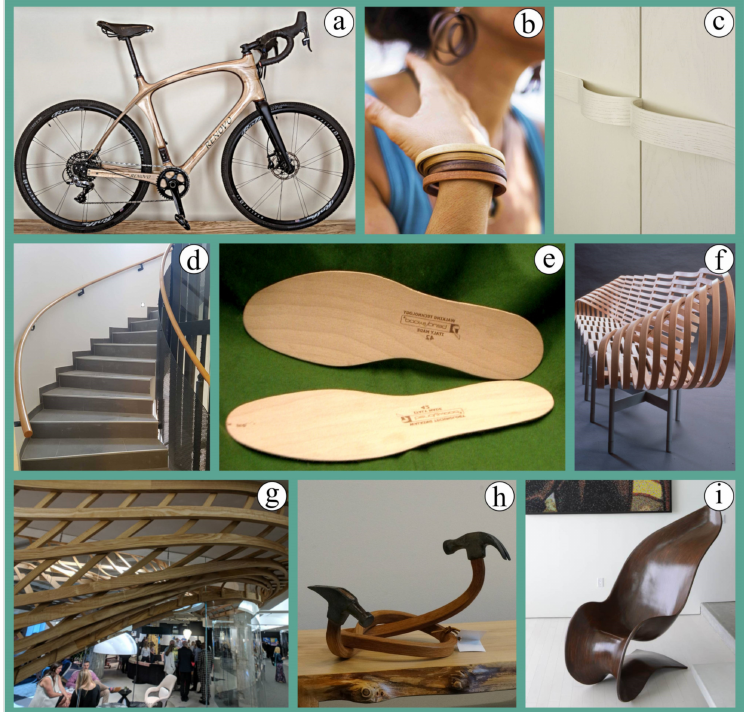
Figure 1. A few possible applications of pleated wood. The montage is made with the permission of the publishers of the reproduced or adapted images, cited in the References. All permissions were issued in 2023. ( a ) Pursuit bicycle (source: [29]); ( b ) Jewellery in Bendywood (source: [30]); ( c ) Bent wooden wardrobe handles (source: [31]); ( d ) Curved wood railings (source: [32]); ( e ) Wooden insoles for shoes (source: [33]); ( f ) Mobius bench (source: [34]); ( g ) 100 feet long organic trellis (source: [35]); ( h ) Hammer heads on bench (source: [36]); ( i ) Gulla chair (source: